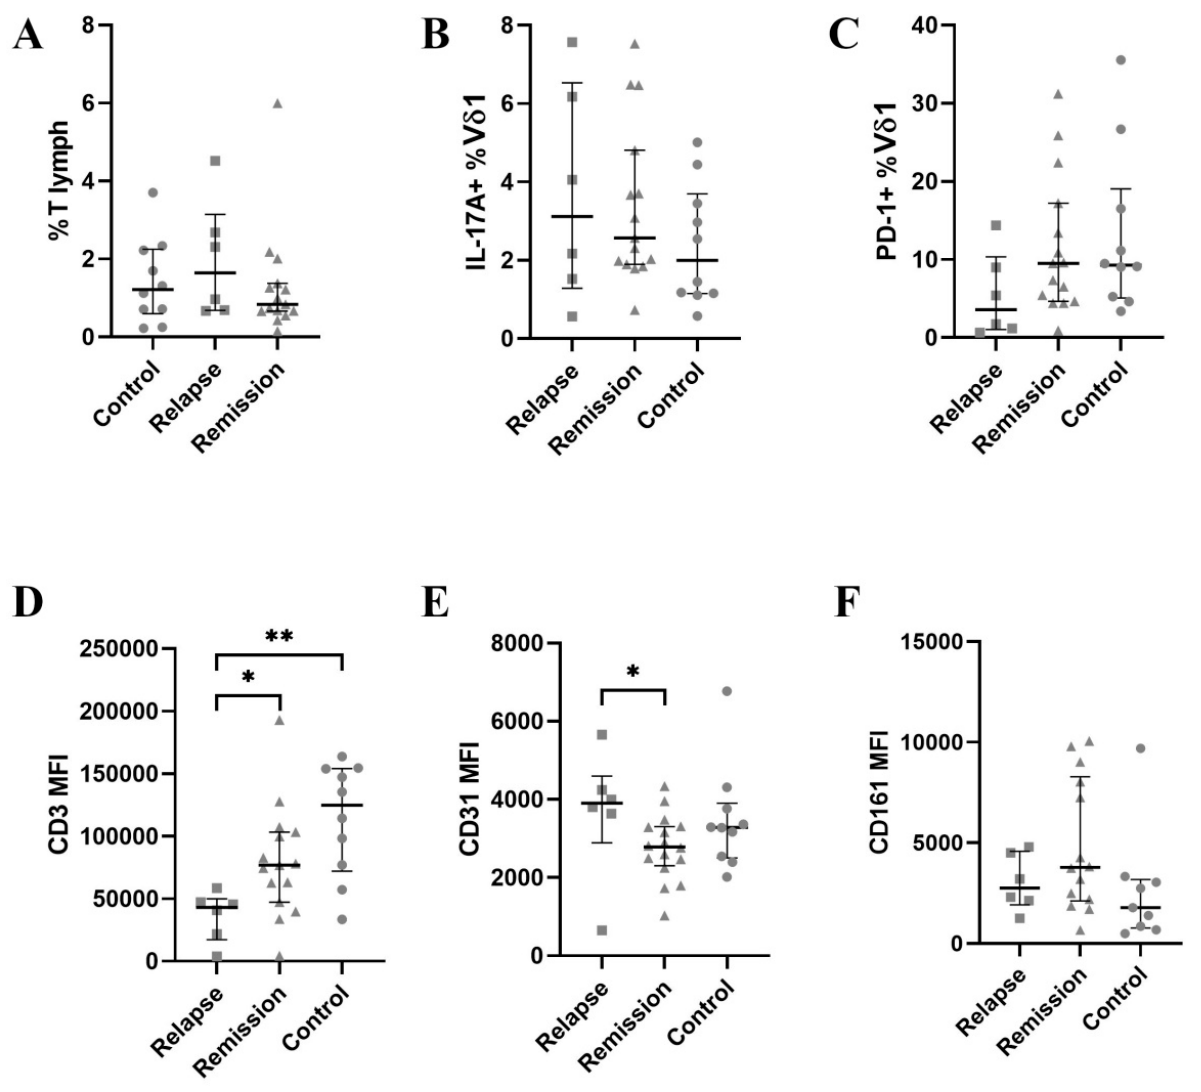
Figure 3. The results for the V δ 1 subset. The horizontal line with whiskers represents the median with inter-quartile range (IQR). ( A )—percentage of V δ 1 among total T cells, ( B )—percentage of IL-17+ V δ 1 cells, ( C )—percentage of PD-1+ V δ 1 cells, ( D – F )—MFI values for CD3, CD31 and CD161 respectively. MFI—mean fluorescence intensity. * denotes p < 0.05, ** p < 0.01.